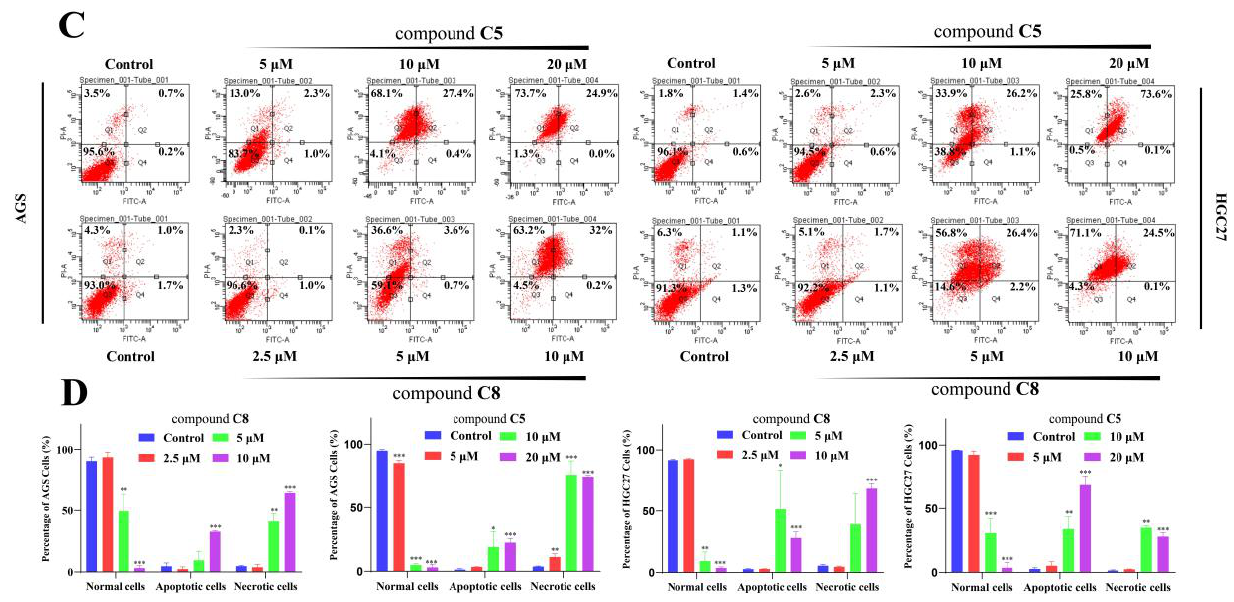
Figure 4. Effects of different concentrations of compounds C5 or C8 on AGS cell cycle and cell apoptosis after treatment for 24 h or 48 h. ( A ) Effects of different concentrations of compounds ( C5 ) and C8 on AGS and HGC27 cell cycle after 24 h treatment. ( B ) Analysis of the proportion of AGS and HGC27 cells, at different cell stages, before and after treatment with compounds C5 or C8 . ( C ) Statistical analysis of apoptosis percentage of AGS and HGC27 cells. ( D ) Treatment of AGS or HGC27 cells, with different concentrations of compound C5 or C8 for 48 h, caused cell necrosis.